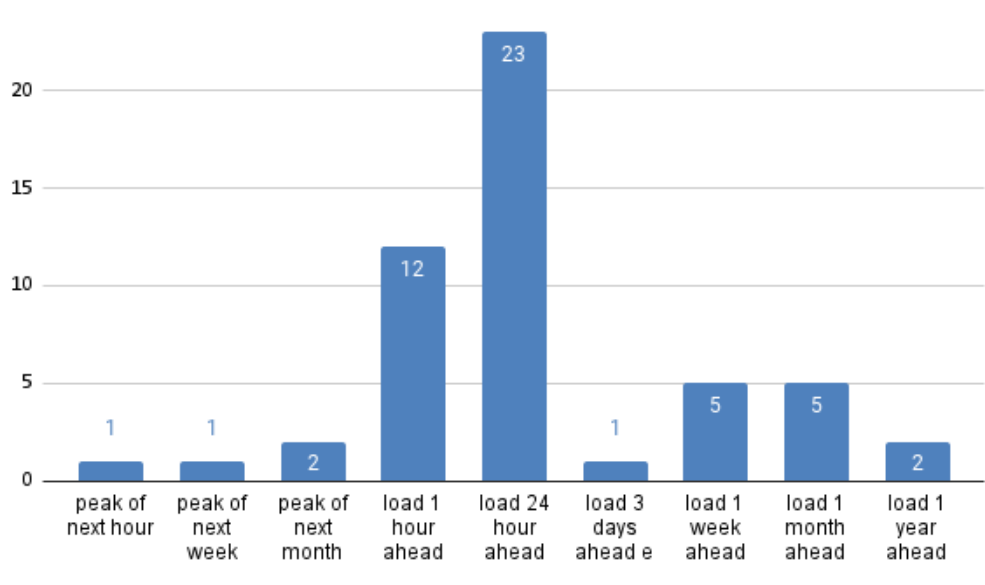
Figure 2. Output variables of the reviewed papers that focus on STLF and MTLF. Some papers are counted in several